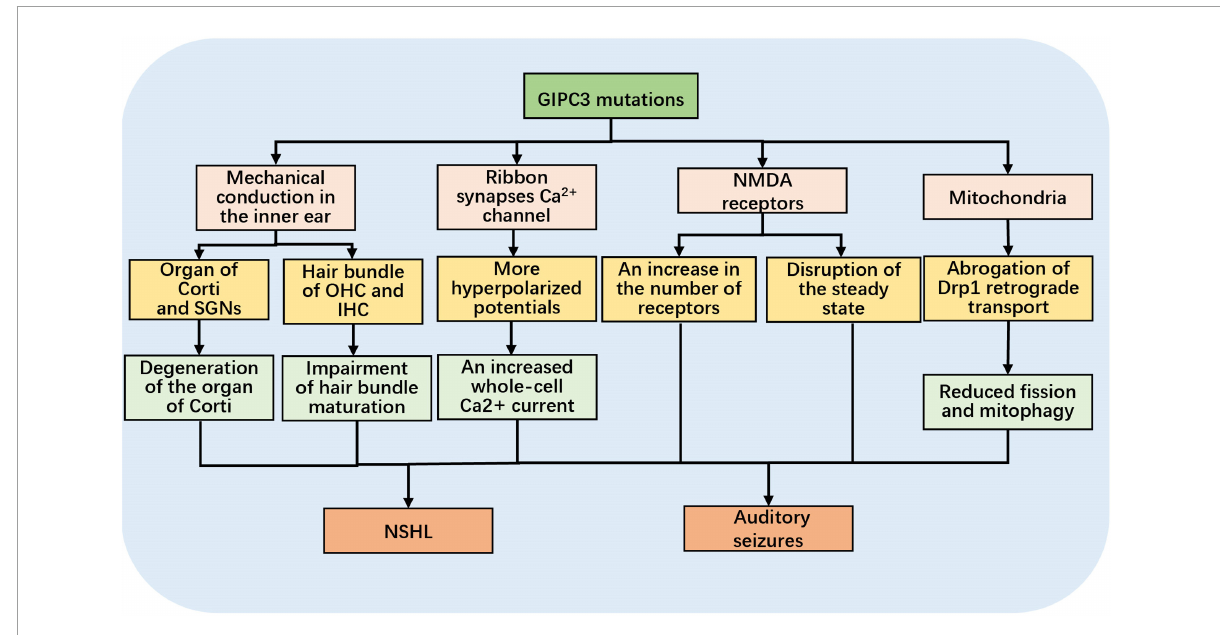
FIGURE1 Schematic diagram of the mechanisms of hearing loss and acoustic seizures triggered by GIPC3